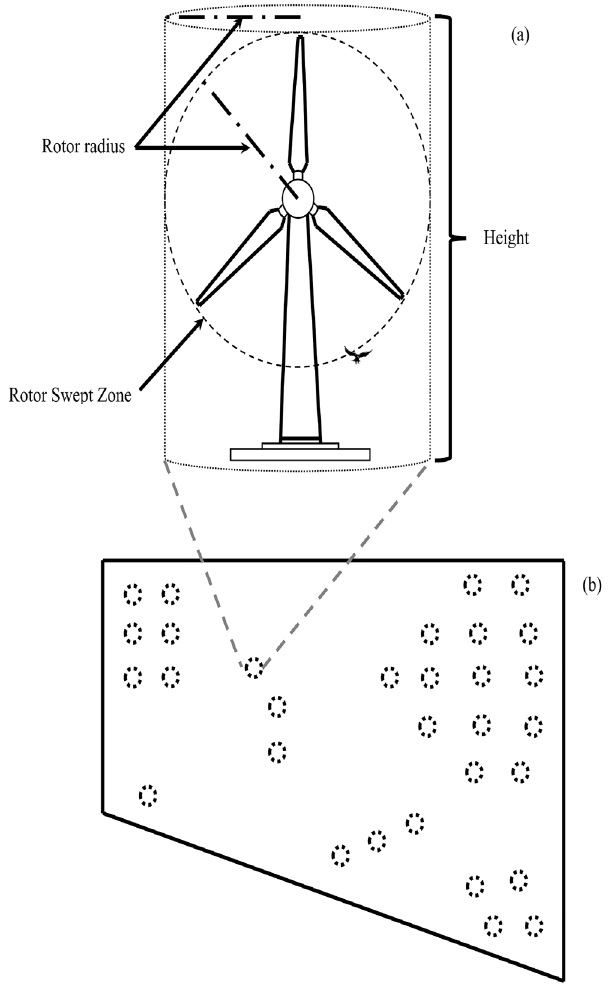
Fig 1. Diagram of a wind turbine and proposed project layout. The total hazardous volume (dotted line) for each turbine (a) is calculated using the rotor radius and the turbine height rather than just the rotor swept area. The total hazardous volume informs a wind facility ’ s hazardous footprint (circles) once the number of turbines within the project ’ s boundaries (solid line) is taken into account